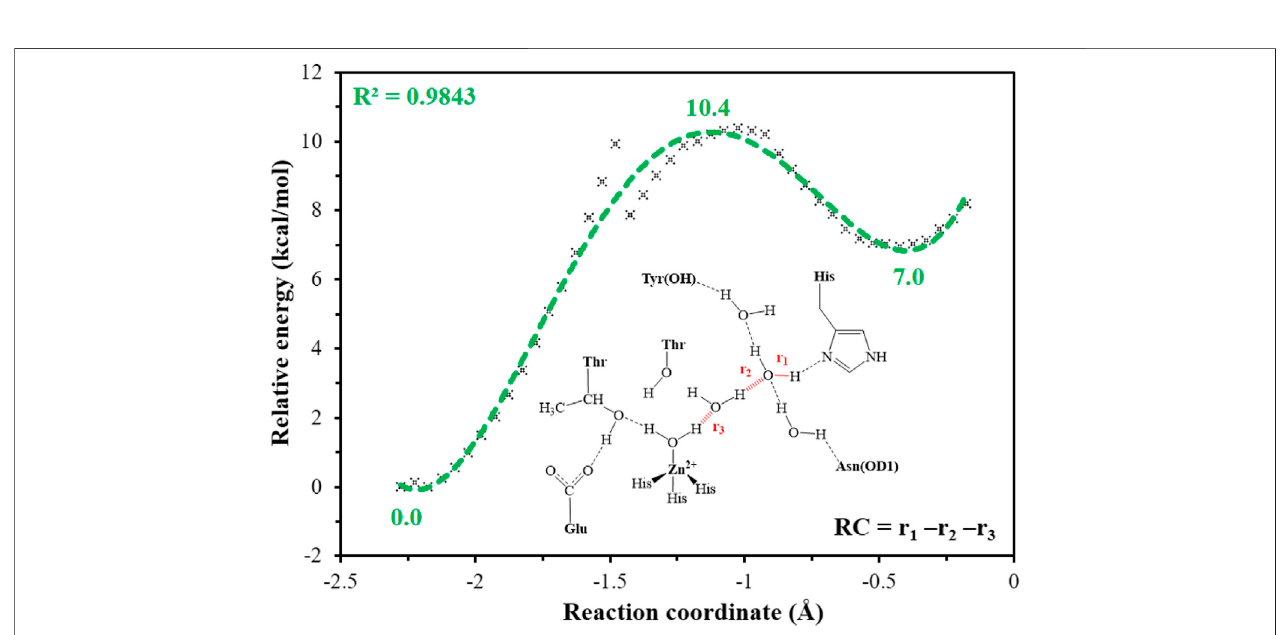
FIGURE 5 | QM(B3LYP/TZVP – D3)/MM-predicted relative energy pro fi les for the proton transfer between H64 and WT1, where the reaction coordinate is de fi ned as r 1 — r 2 — r 3 (in red).